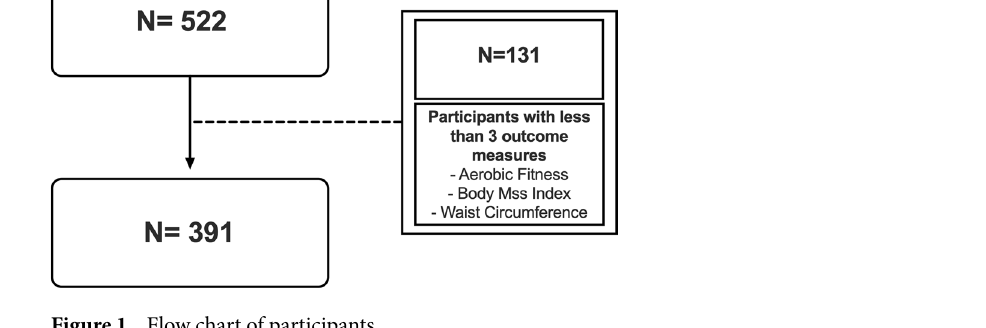
Figure 1. Flow chart of